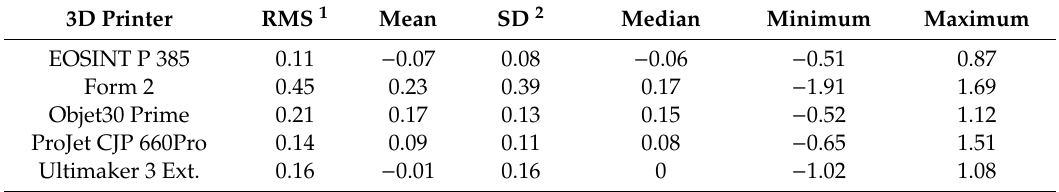
Table 3. Summary of all trueness analyses values (mm) for each 3D printer.